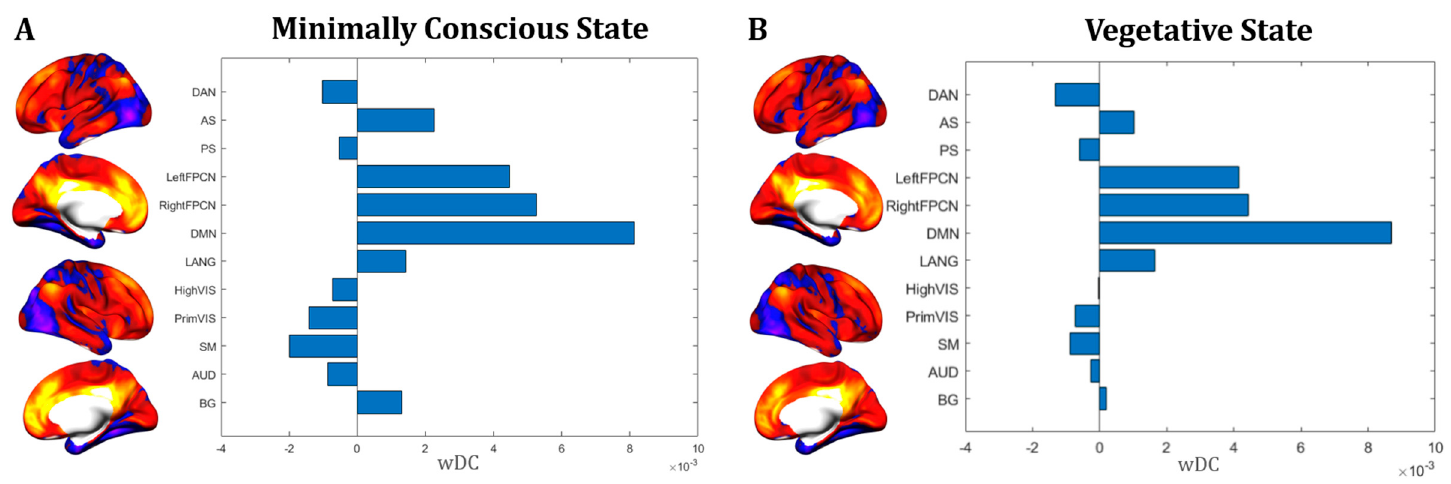
Figure 8. MCS, VS and RSNs. The functional connectivity profile and the similarity coefficient with RSNs is shown separately for MCS ( A ) and VS ( B ). A similar network profile was identified for both MCS and VS patients, with major overlap with DMN and FPCN as shown for Network #1.